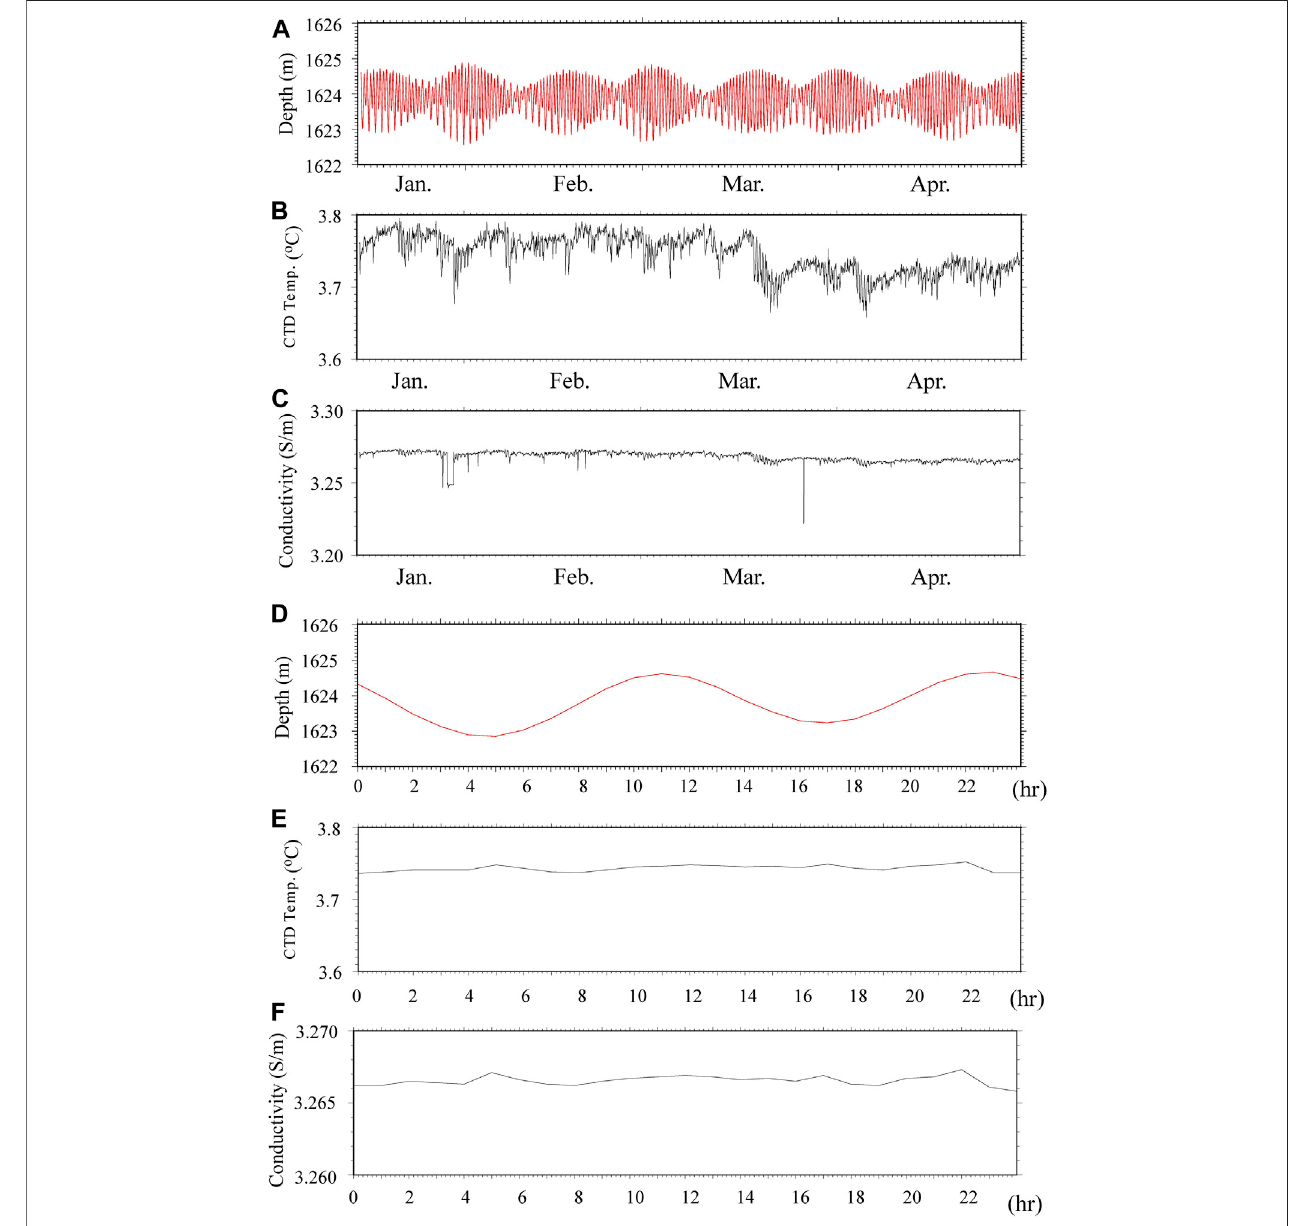
FIGURE 8 | Time series of (A) the pressure meter (depth) and (B,C) the ambient temperature and electrical conductivity throughout the observation period (D – F) Same as (A – C) , but with data for April 30, 2018.